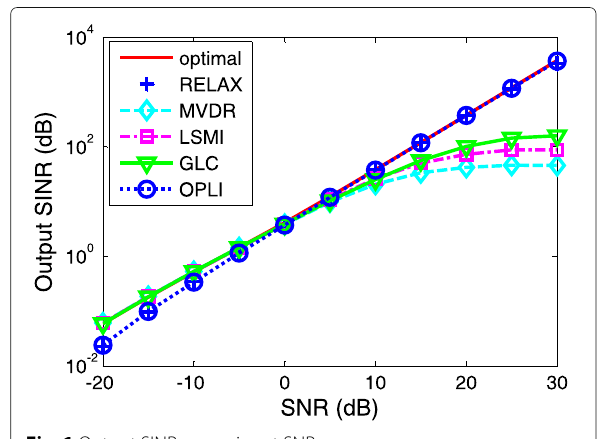
Fig. 1 Output SINR versus input SNR